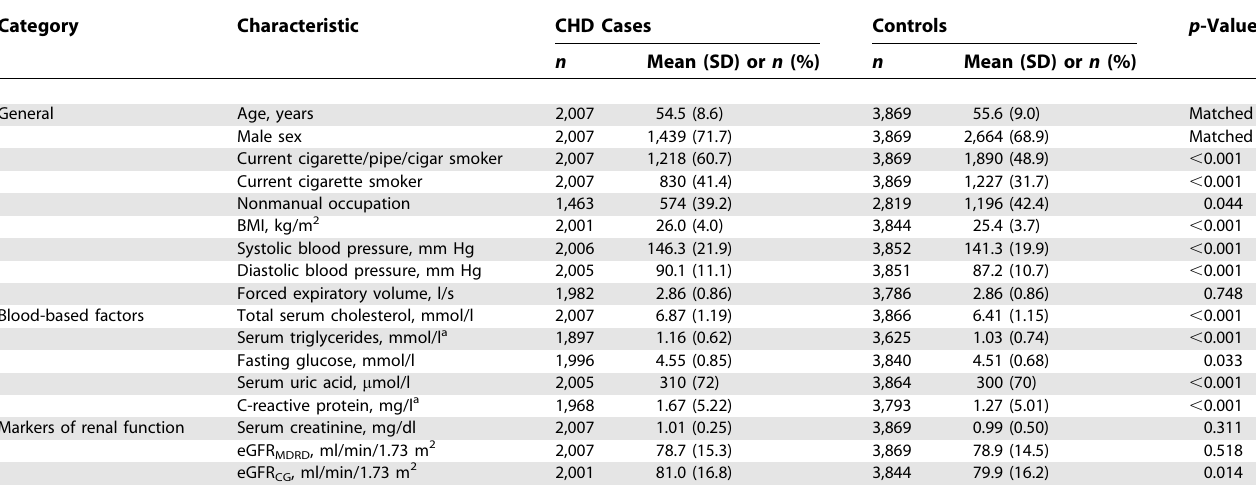
Table 1. Baseline Characteristics of Patients Who Developed CHD during the Follow-up and Controls Category